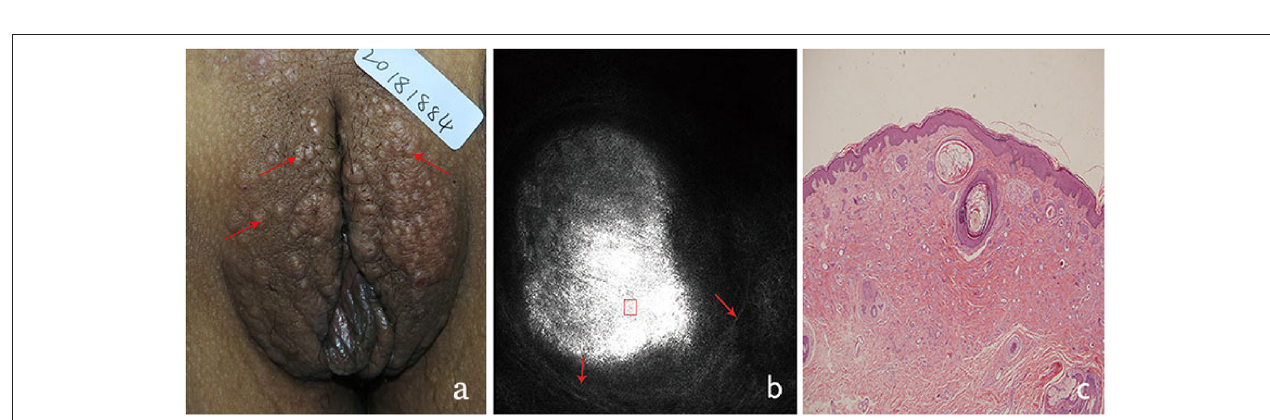
FIGURE 3 | The clinical presentation, RCM findings and histology of vulva syringoma (case 3). (a) , the clinical image of case 3, (b) , the RCM image findings; (c) , the histological findings. The presence of round to oval high refractive, and relatively monomorphous mass of varing sizes (the red square)was present in the upper dermis, with 1–2 layers of surrounding light-dark line structures (red arrowhead)in (b) .